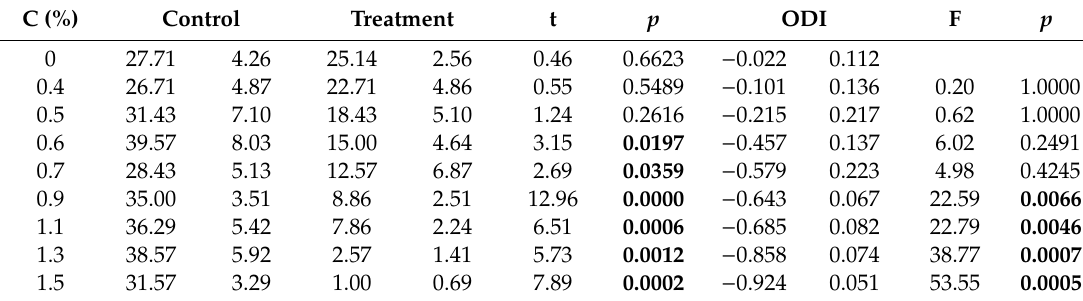
Table 5. Number of eggs laid in control dish and treatment Petri dish and oviposition deterrence index (ODI) (means and standard errors for 7 replicates) depending on thyme oil concentration (C). Significant di ff erences are given in